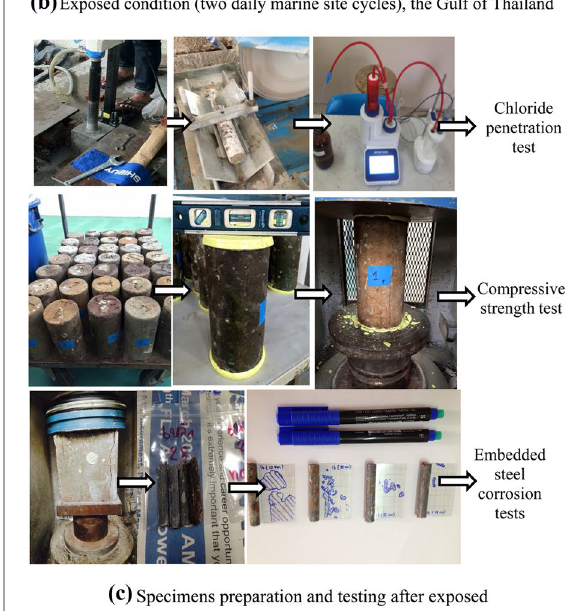
Fig. 1 Specimens preparation and testing of exposed